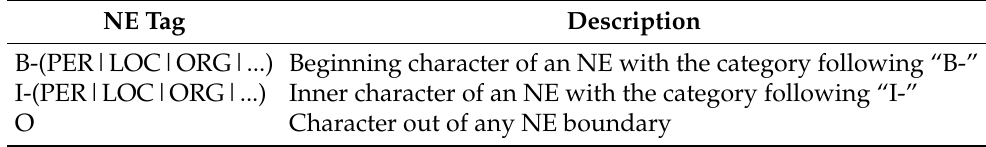
Table 2. Character-unit NE